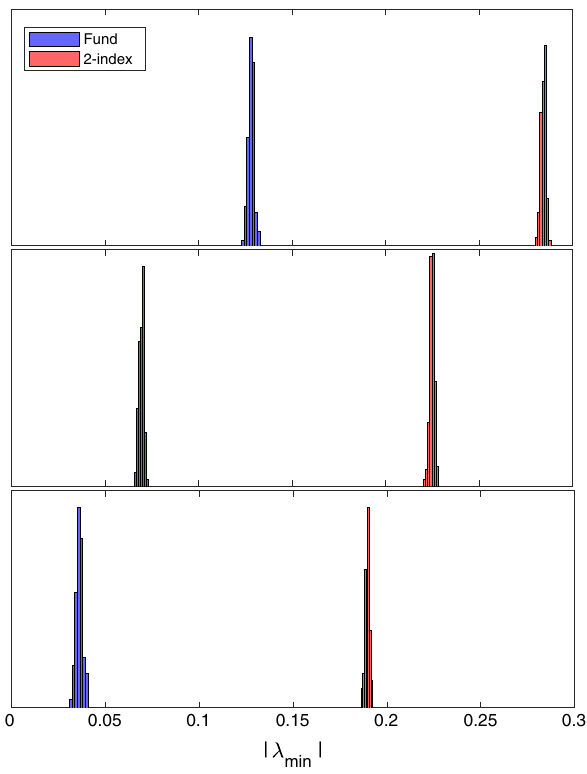
Fig. 7 Distribution of the minimum eigenvalue of γ 5 D in the funda- mental (blue) and two-index antisymmetric (red). The critical line is approached from the top to the bottom corresponding to bare fermion masses am 4 = am 6 = [− 0 . 50 , − 0 . 55 , − 0 . 58 ] . We observe that for degenerate bare fermion masses the fundamental representation is lighter than the two-index antisymmetric one, i.e. (cid:4)| λ Fund This result is consistent with the hierarchies found in PCAC quark masses and in “pion-like” effective masses displayed in Fig. 6. This observation is also compatible with the results reported in Ref.